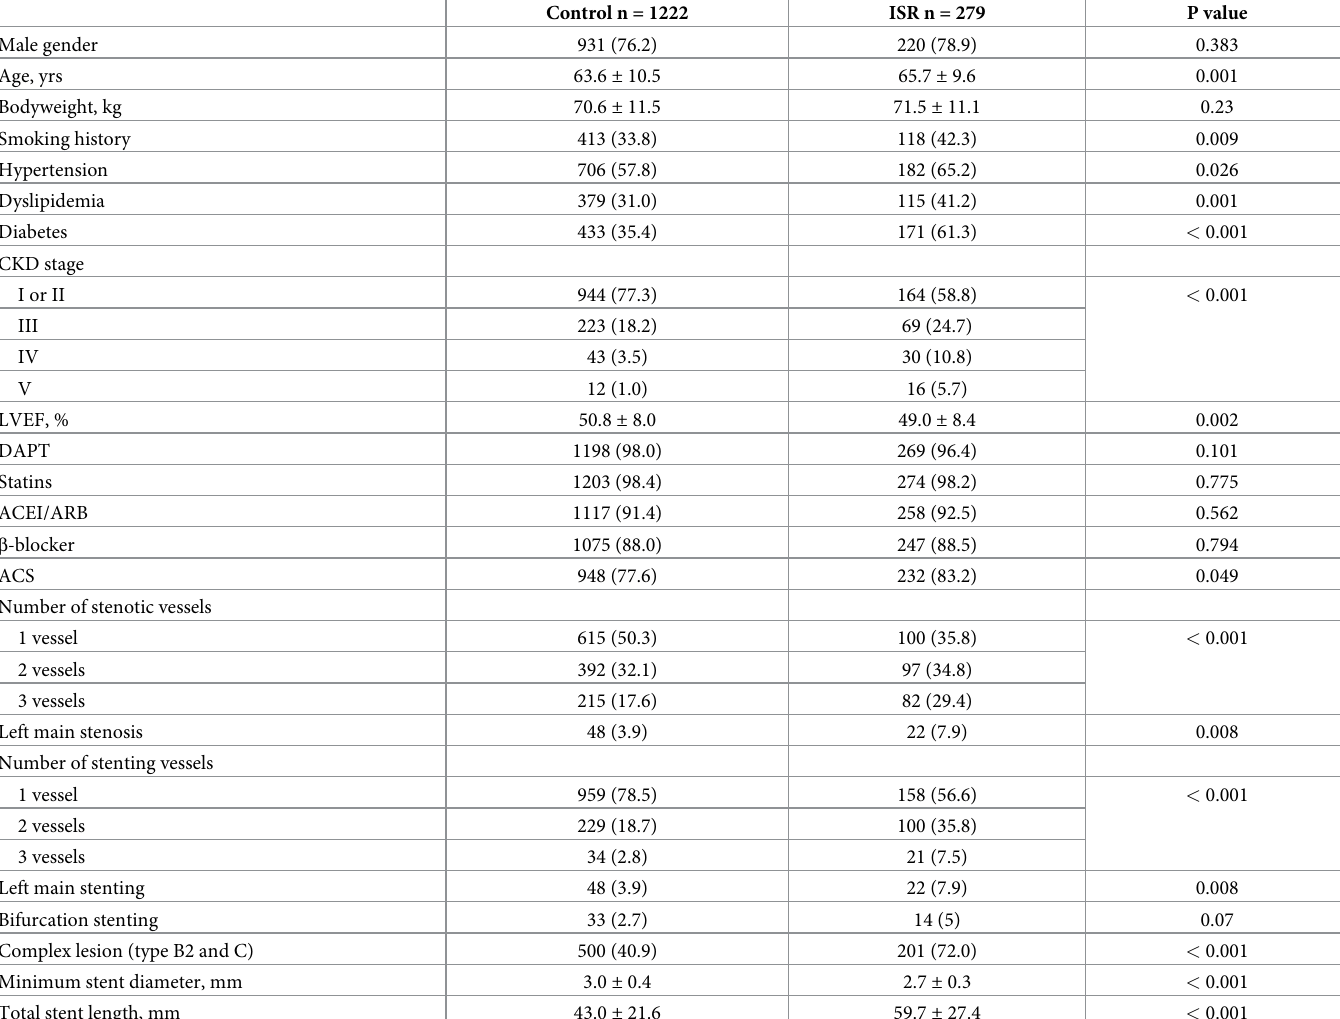
Table 1. Baseline